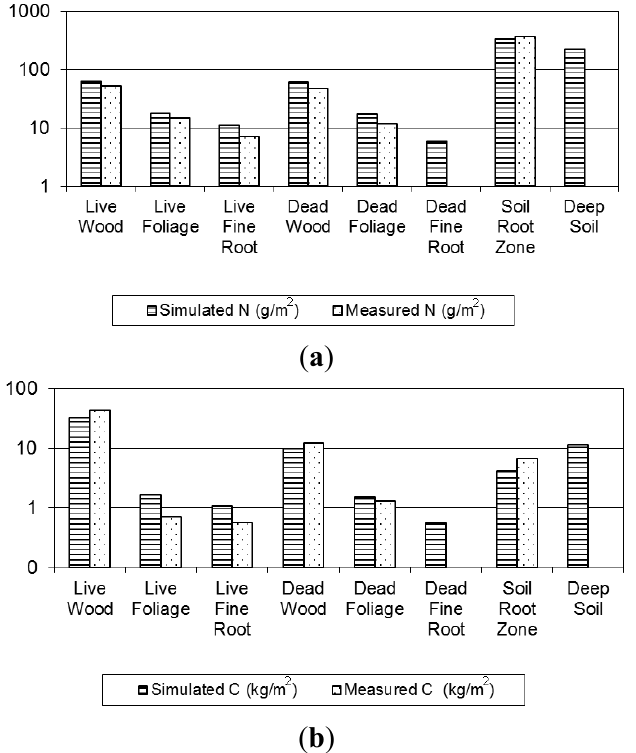
Figure 2. A comparison of simulated stocks of nitrogen ( a ) and carbon ( b ) against budget